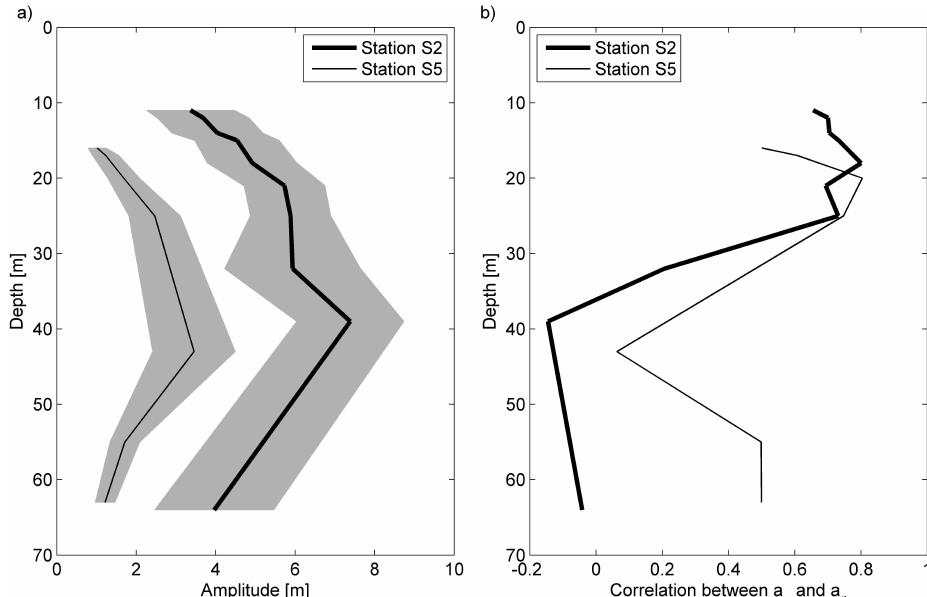
Fig. 8. (a) Amplitude of the vertical displacements of different density surfaces as a function of depth at station S2 (thick lines) and station S5 (thin lines). The mean amplitude is plotted with lines, and grey shaded areas indicate the mean amplitude ± one standard deviation. (b) Correlation coefficient between the amplitude of the surface elevation and the amplitude of the vertical displacement of different density surfaces as a function of depth for station S2 (thick line) and station S5 (thin line).